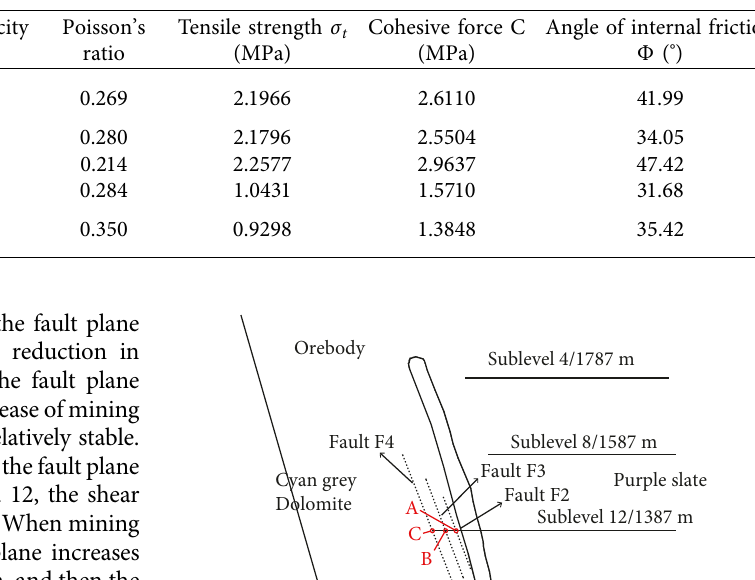
Figure 5: 3D discrete cell method 3DEC model cross-sectional logical block distribution profile. Table 1: Macroscopic rock mechanics parameters of Shizishan Copper Mine.